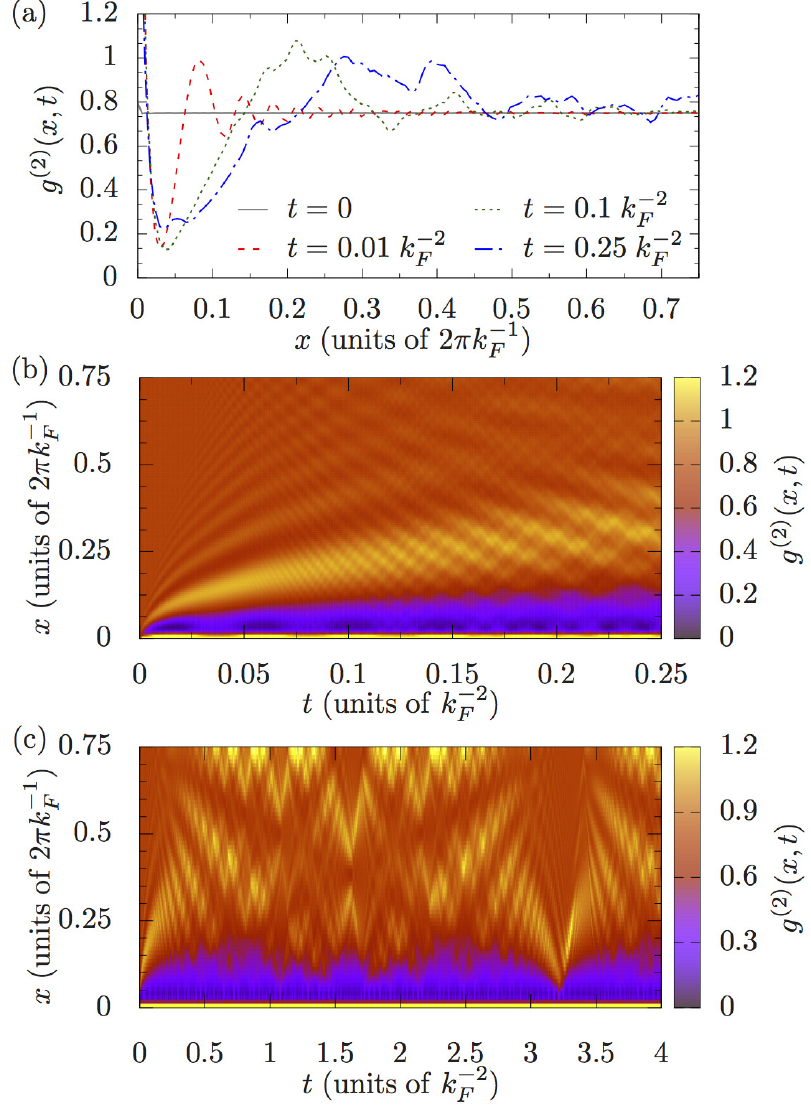
Figure 9: Time evolution of the nonlocal second-order correlation function g ( 2 ) ( x , t ) following a quench from the ideal-gas ground state to γ = − 40 for N = 4 particles. (a) Correlation func- tion g ( 2 ) ( x ) at four representative times. (b) Evolution of g ( 2 ) ( x , t ) for short times t ≤ 0.25 k − 2 F and (c) longer times t ≤ 4 k − 2 . Note that the colour scale has been chosen so as to preserve F ) is not resolved. the visibility of long-range features, and thus g ( 2 ) ( x , t ) for x (cid:174) 0.02 × ( 2 π k − 1 F The local value oscillates between g ( 2 ) ( 0, t ) (cid:39) 2 and (cid:39) 4, cf. Sec. 4.2. [ cf. Figs. 7(c) and 8(b) ] . Besides the significantly of g ( 2 ) ( x , t = 0 ) at t (cid:39) 3.2 k − 2 F